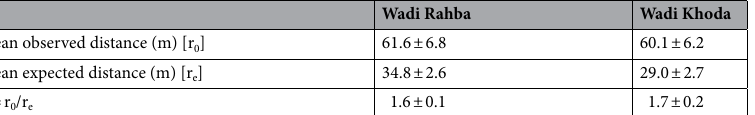
Table 2. Distribution pattern of the Vachellia tree taxa in wadi Khoda and wadi Rahaba, Gebel Elba National Park, south-eastern Egypt. Statistical analyses of these data are provided in the